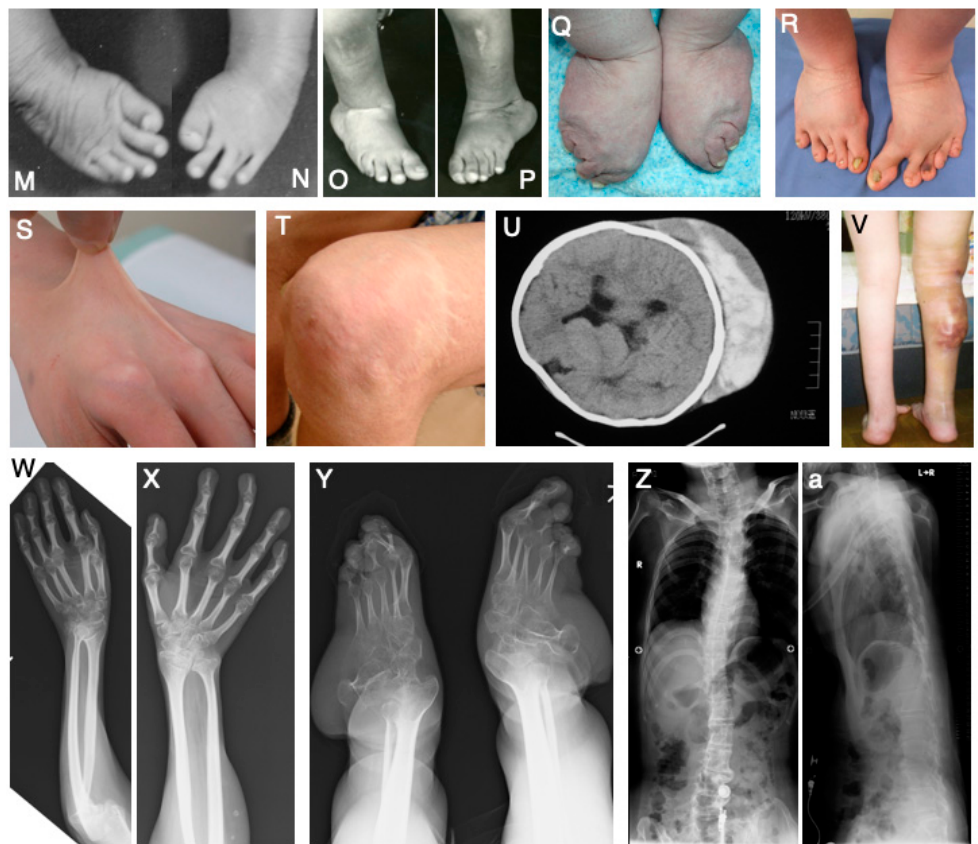
Figure 1. Clinical photographs and radiological images of patients with mcEDS- CHST14 . Clinical photographs of a patient with heterozygous variants Pro281Leu / Try293Cys at age 23 days ( A ), 3 years ( B ), and 16 years ( C , D ); those of a patient with a homozygous variant Pro281Leu at age 2 months ( H , M , N ), 3 months ( I ), 6 years ( O , P ), and 28 years ( J , Q ); photographs of a patient with a homozygous variant “P281L” in the neonatal period ( E ) and at age 30 years ( F , G , T ); and photographs of a patient with heterozygous variants Pro281Leu / Cys289Ser at age 1 month ( K ), 16 years ( V ), and 19 years ( L , R , S ) [5]. Radiological image of a patient with heterozygous variants Pro281Leu / Try293Cys at age 6 years ( U ); images of a patient with a homozygous variant Pro281Leu at age 28 years ( W – Z , a ) [5,13]. (U, reproduced from Kosho et al. Am. J. Med. Genet. Part A 2005 , 138A , 282–287, with permission from Wiley-Liss, Inc.; the other images, reproduced from Kosho et al. Am. J. Med. Genet. Part A 2010 , 152A , 1333–1346, with permission from Wiley-Liss,